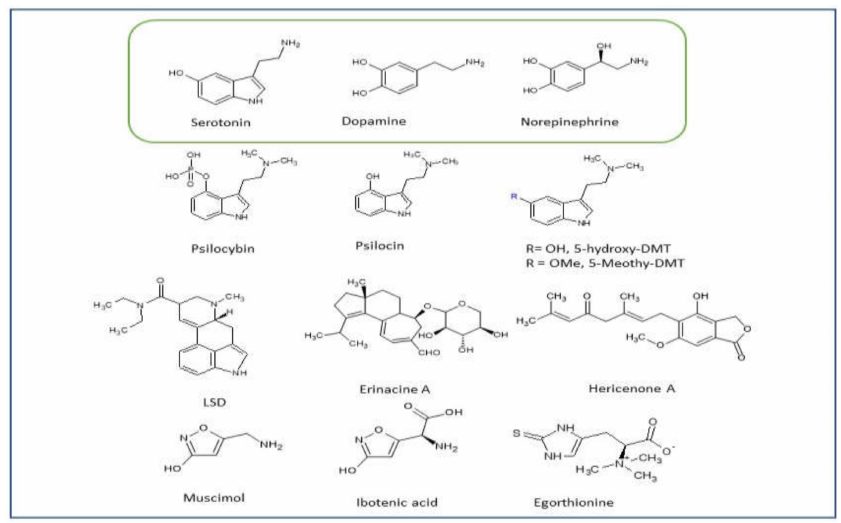
Figure 1. Monoamine neurotransmitters and fungal